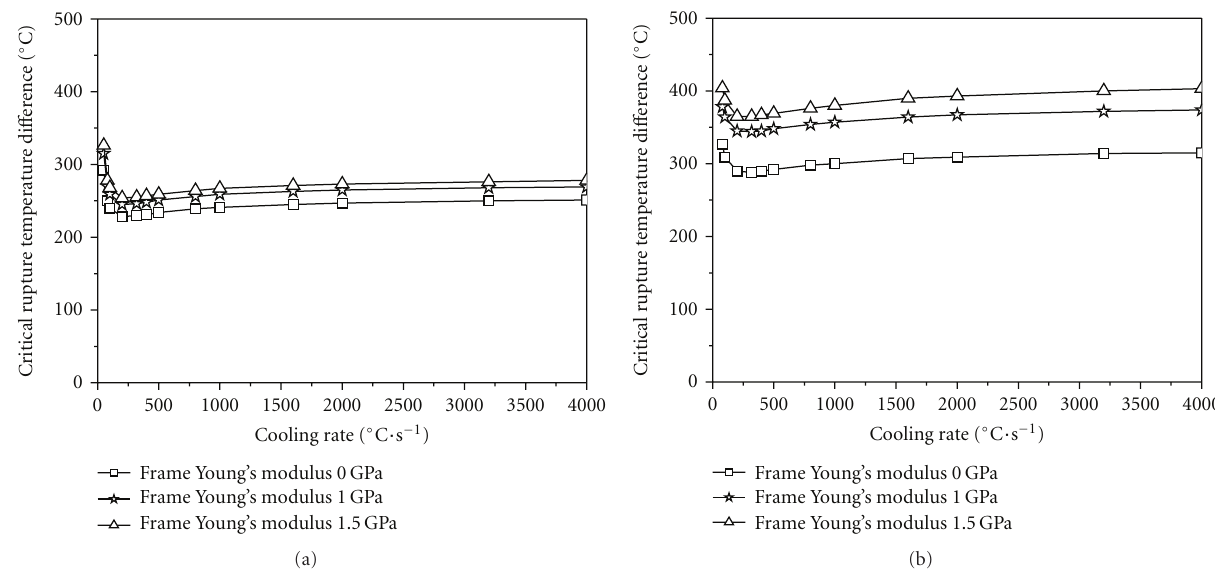
Figure 6: The critical rupture temperature di ff erence versus cooling rate for di ff erent frame Young’s modulus with the thermal shock initial temperature (a) 1500 ◦ C and (b) 1900 ◦ C.